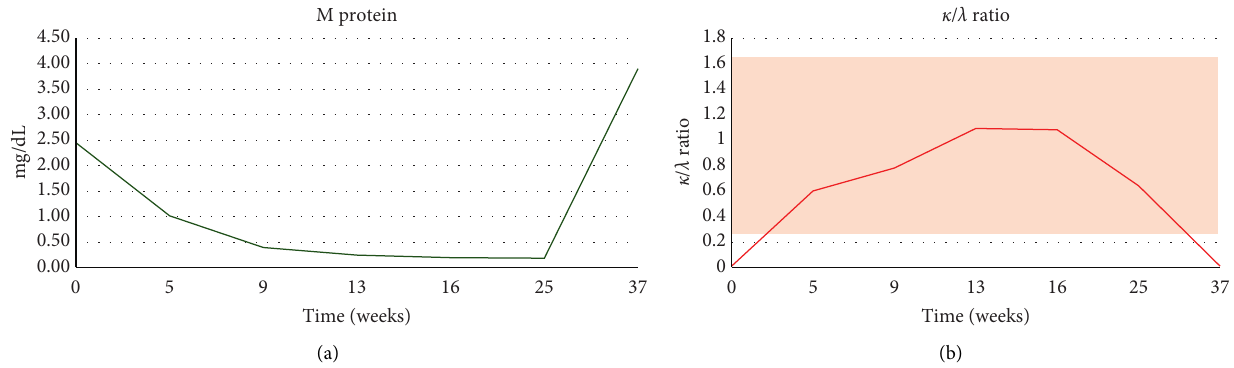
Figure 1: Response to treatment. (a) M protein levels after initiation of treatment with vemurafenib and cobimetinib at 0, 5, 9, 13, 16, 25, and 37 weeks. (b) Changes in kappa/lambda ratio at 0, 5, 9, 13, 16, 25, and 37 weeks. The beige box shows the normal range of the kappa/lambda